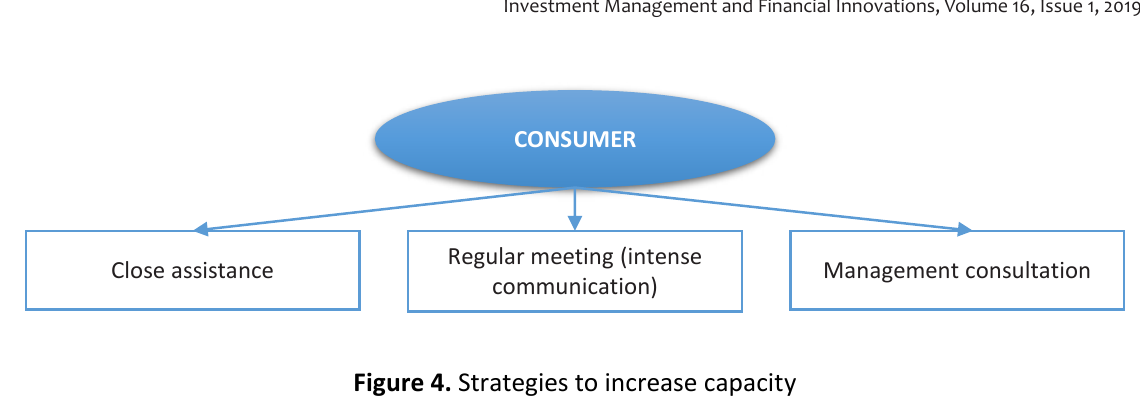
Figure 4. Strategies to increase